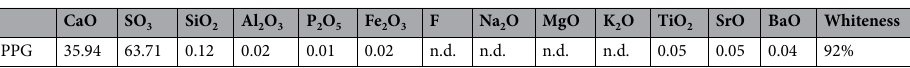
Table 2. Chemical composition and whiteness of PPG. n.d. not detected.